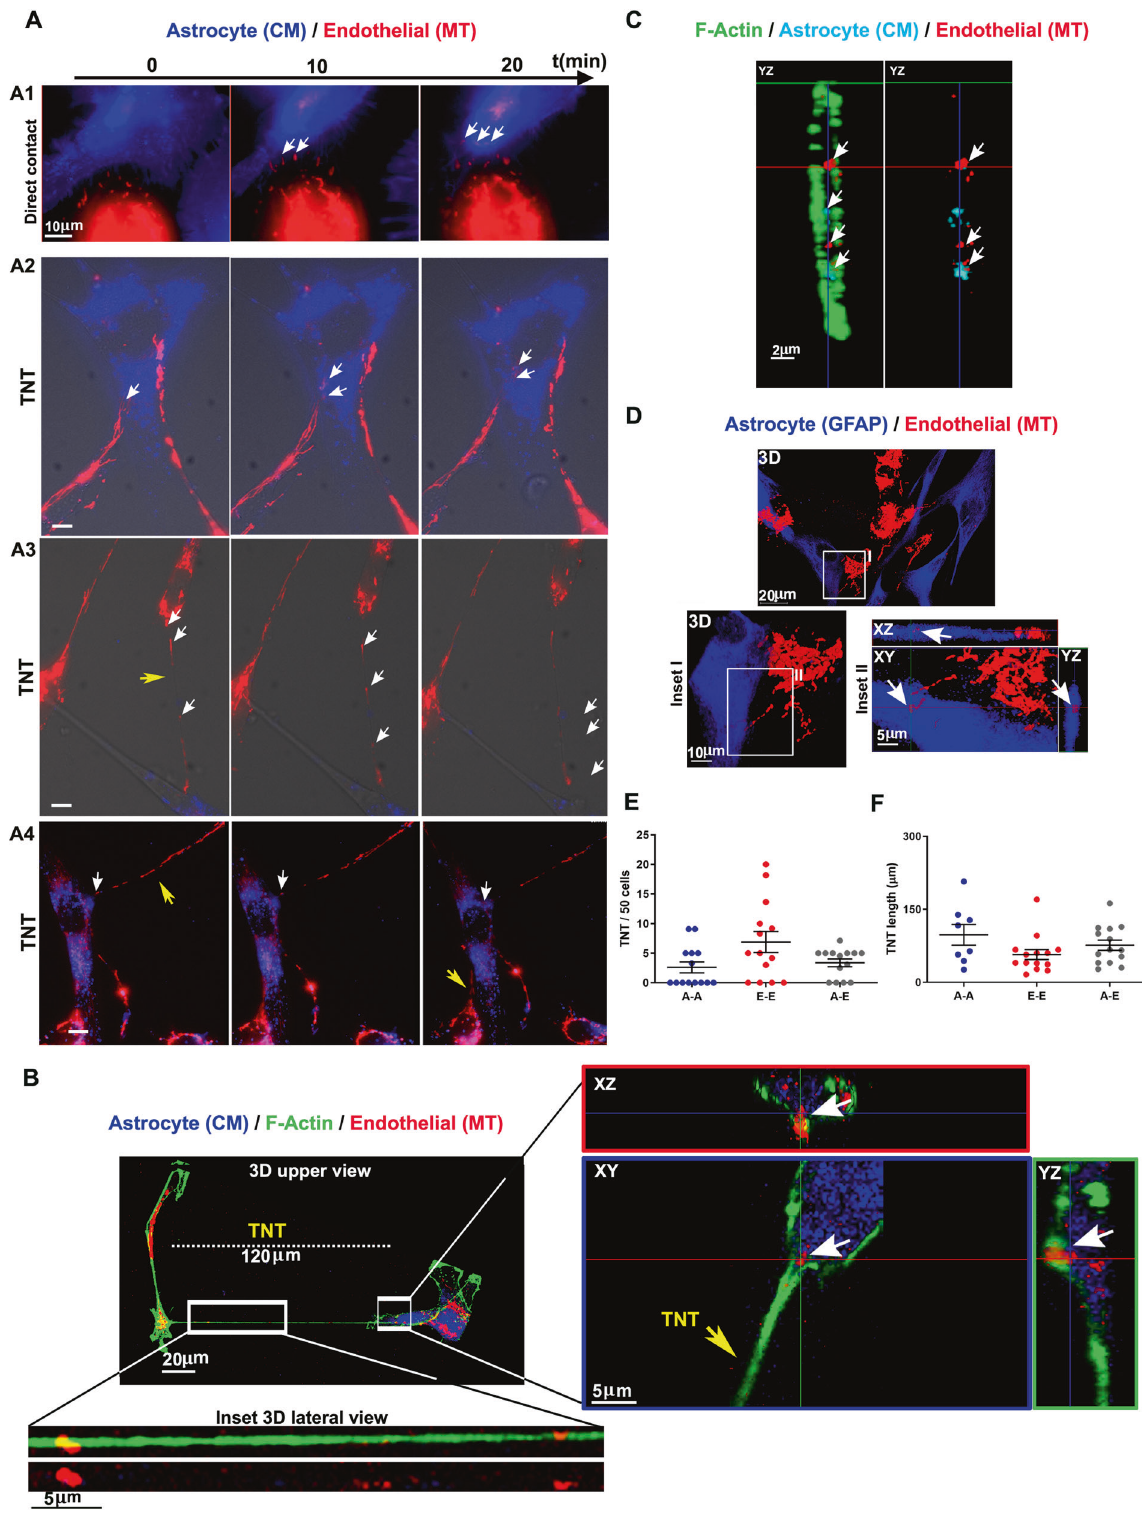
analyzed by immuno fl uorescence using anti-GFAP antibodies and focusing on the confocal planes corresponding to the assembloid core (50 μ m depth). Mitochondria of endothelial and pericytic origin were found inside GFAP-positive astrocytes when the